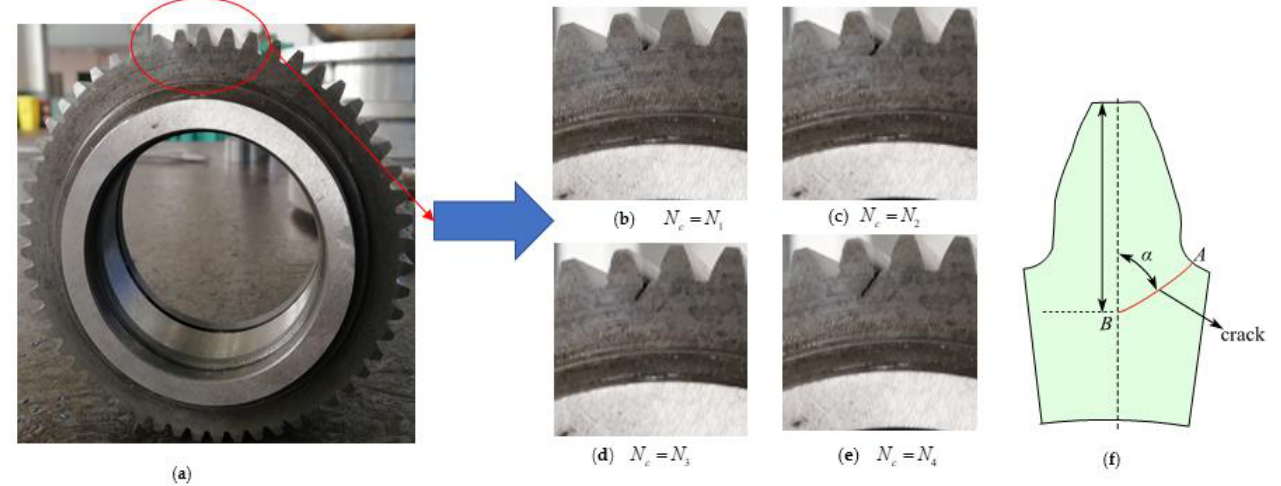
Table 4. Cycle numbers and angles recorded for tooth root fatigue cracks.